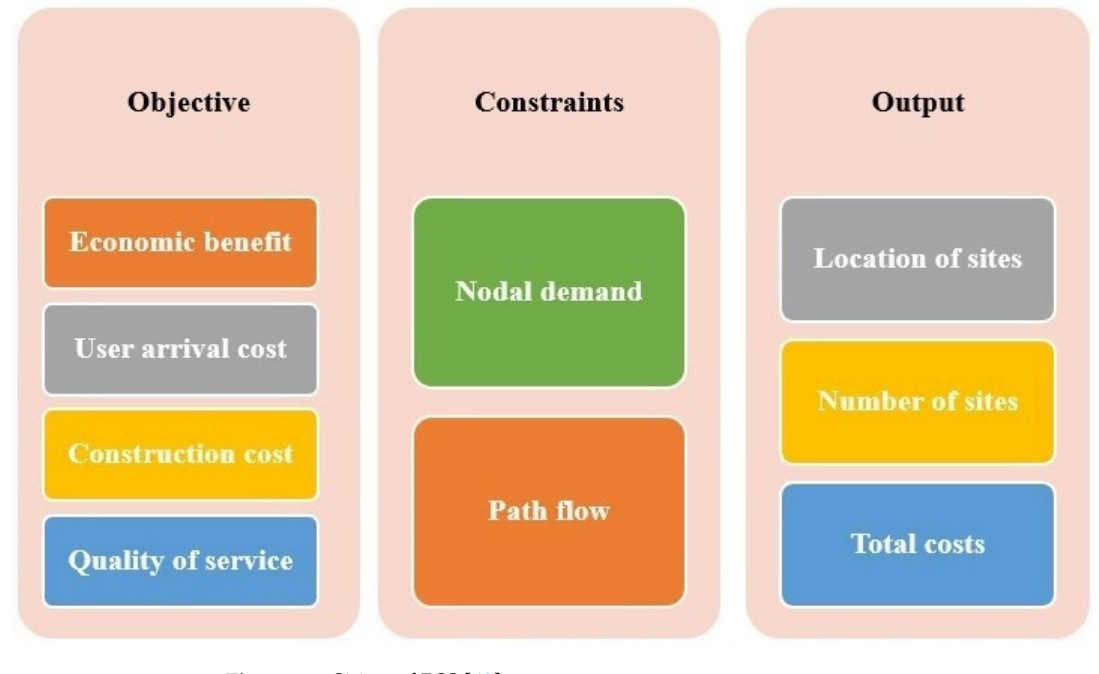
Figure 11. Siting of BSS [62].